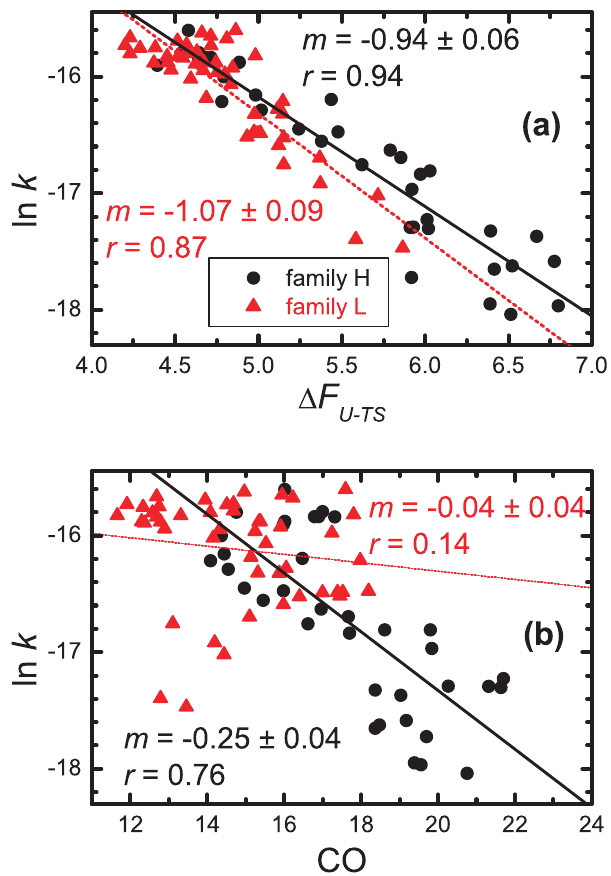
Figure 4. Dependence of the logarithm of the folding rate k on (a) the activation energy of folding, and (b) the contact order of the corresponding native structure, for the two families of circular permutants considered in this work. We also report the slopes ( m ) and the absolute values of the correlation coefficients ( r ) for the corresponding linear